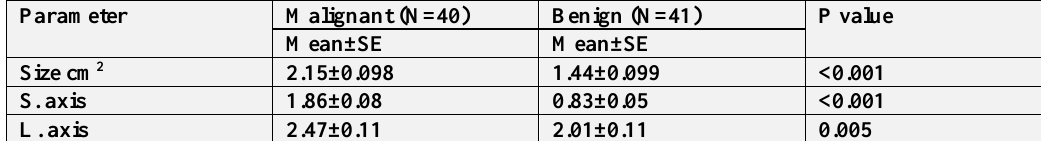
Table (7) : Size of the involved L.Ns measured by US